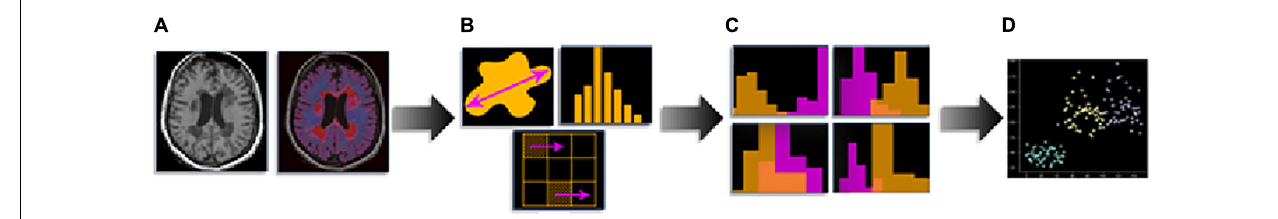
FIGURE 1 | Radiomics pipeline: (A) medical imaging and segmentation, (B) feature extraction, (C) feature selection, and (D) modeling.